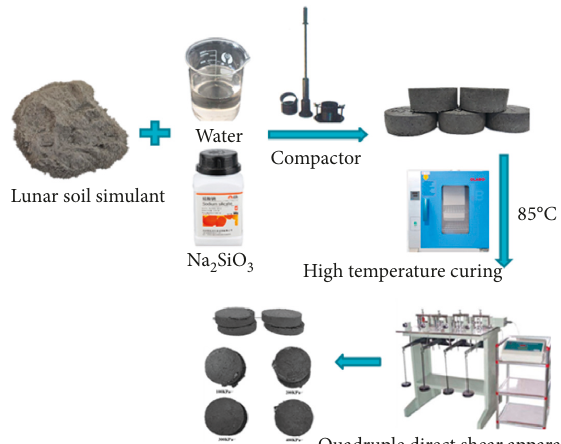
Figure 5: Testing